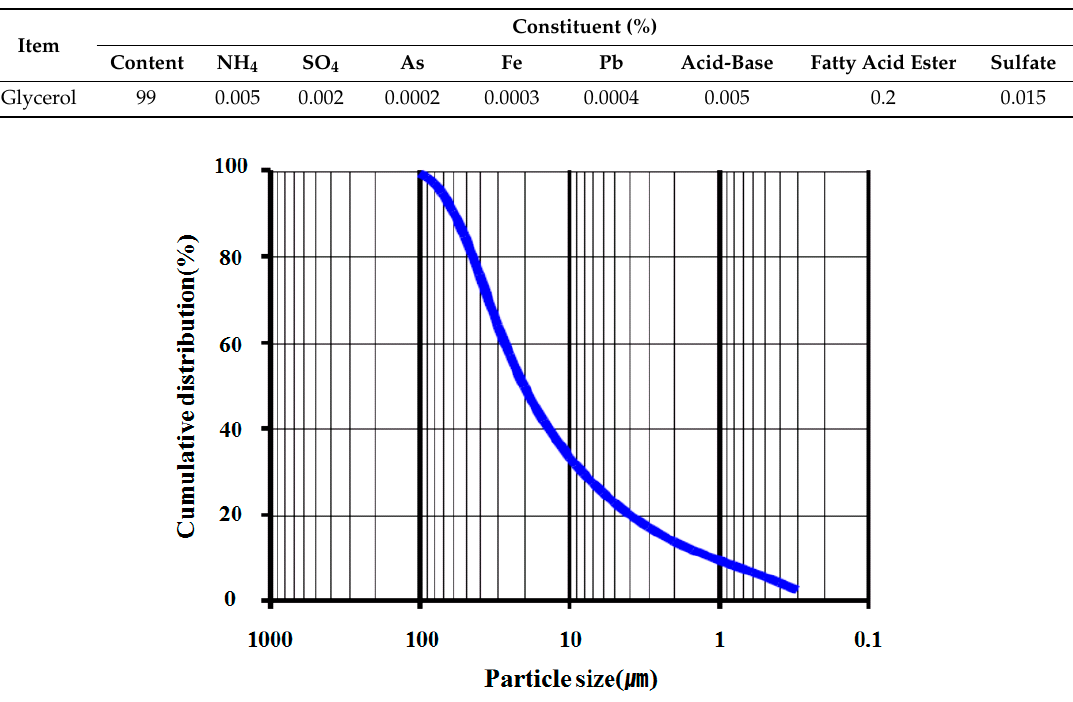
Table 2. Analysis of glycerol components.